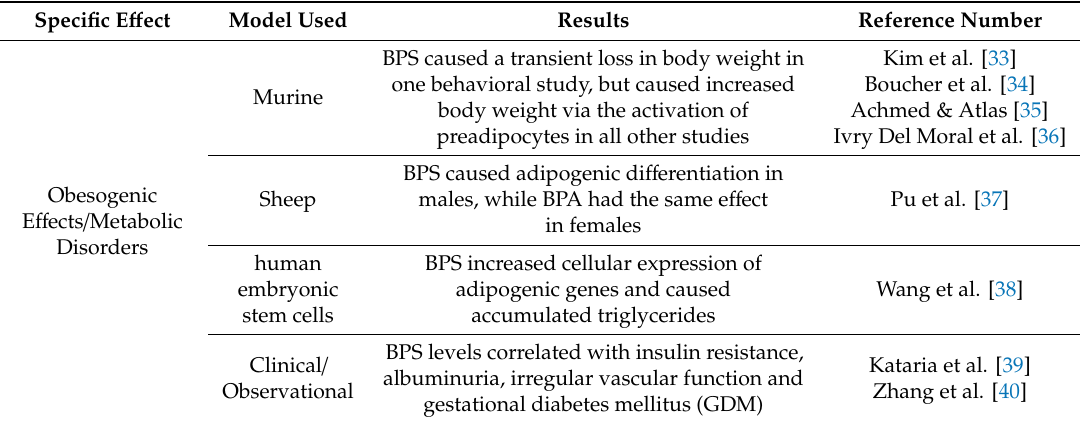
Table 2. Summary of dietary BPS exposure and obesogenic e ff ects / metabolic